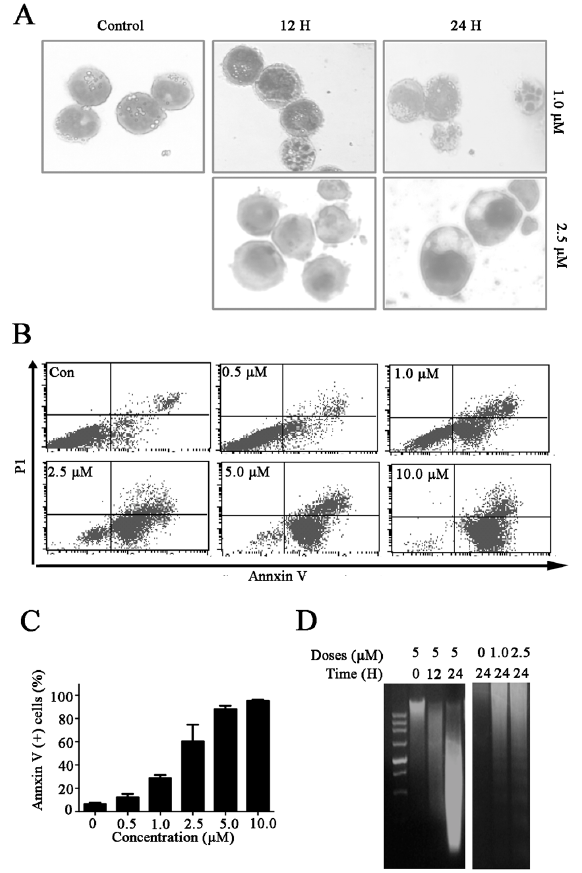
Figure 2. Celastrol induces cell death in Kasumi-1 cells. ( A ) Morphological characteristics of Kasumi-1 cells were treated with the indicated concentrations of celastrol for different periods of time, the changes in morphology were subsequently analyzed; ( B , C ) Celastrol induced cell apoptosis in Kasumi-1 cells. Cells were treated with the indicated concentrations of celastrol for 24 h, and apoptosis was analyzed using Annexin V-FITC/PI double staining and flow cytometry; ( D ) Celastrol induced DNA fragmentation. Kasumi-1 cells were treated with various concentrations of celastrol for the indicated time periods, and purified DNA for DNA fragmentation analysis.